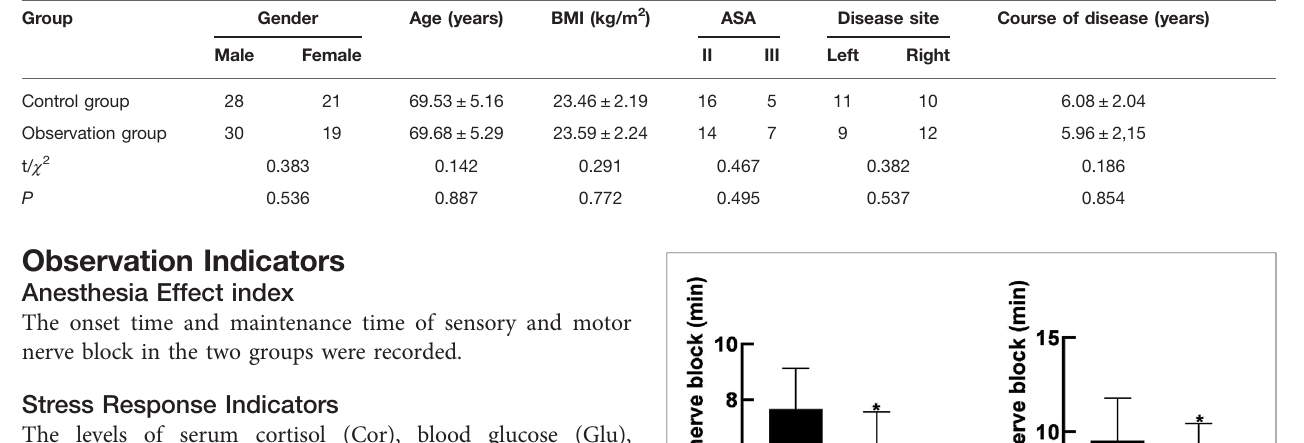
TABLE 1 | Comparison of general data of patients between the two groups.